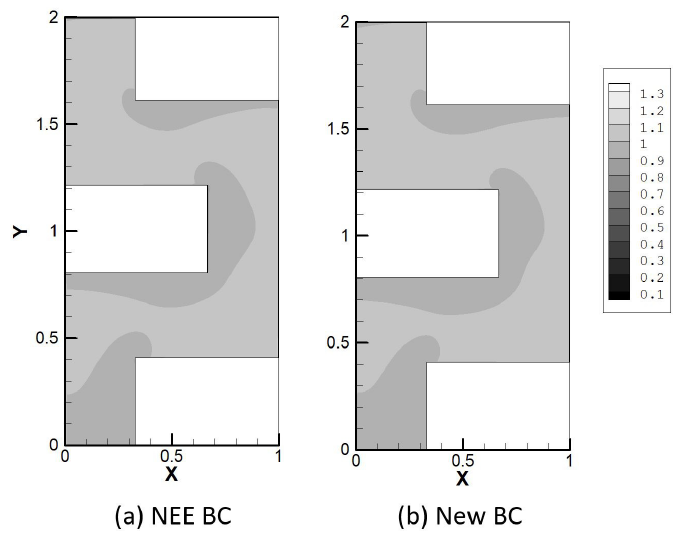
Figure 12. Contours of non-dimensional pressure ( p / p 0 ) in the flow domain: ( a ) New BC; ( b ) NEE